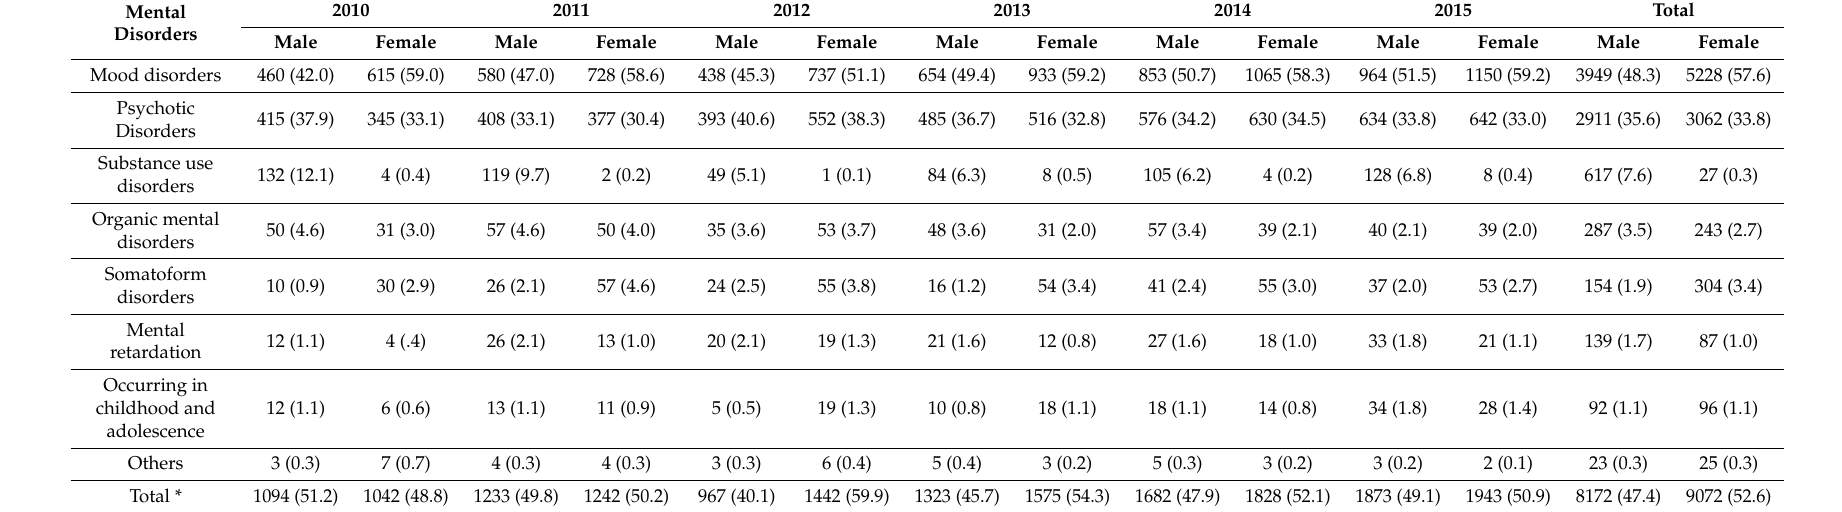
Table 2. The numbers of inpatients with mental disorders in Beijing Anding Hospital by gender, 2010–2015